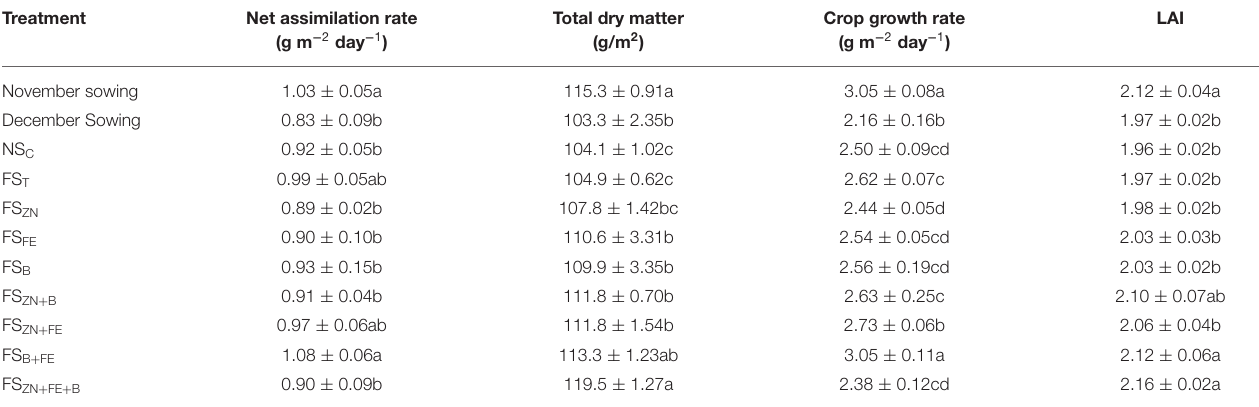
TABLE 3 | Growth parameters of lentil influenced by date of sowing and foliar spray of micronutrients (pooled data of 2 years).